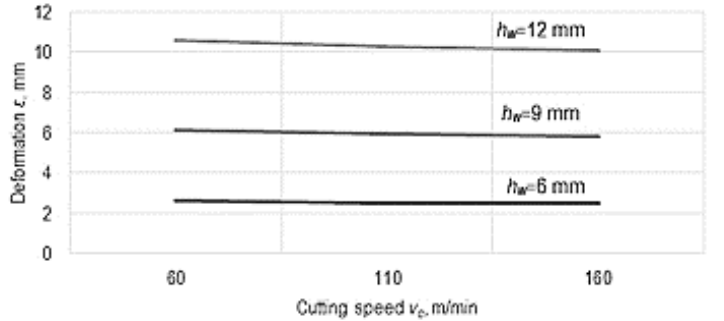
Figure 9. The influence of cutting speed v c on the deformation ε for three different heights of the thin wall ( f z = 0.0045 mm/tooth, t t = 1.2 mm, t w = 0.2 mm, w w = 10 mm).